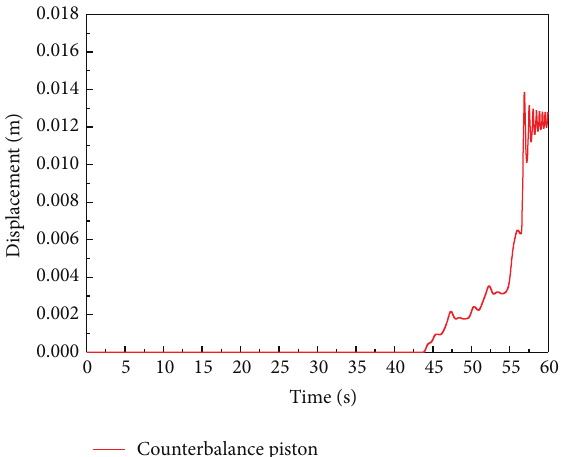
Figure 22: Comparison of flow-pressure curve based on simulation and experiment.